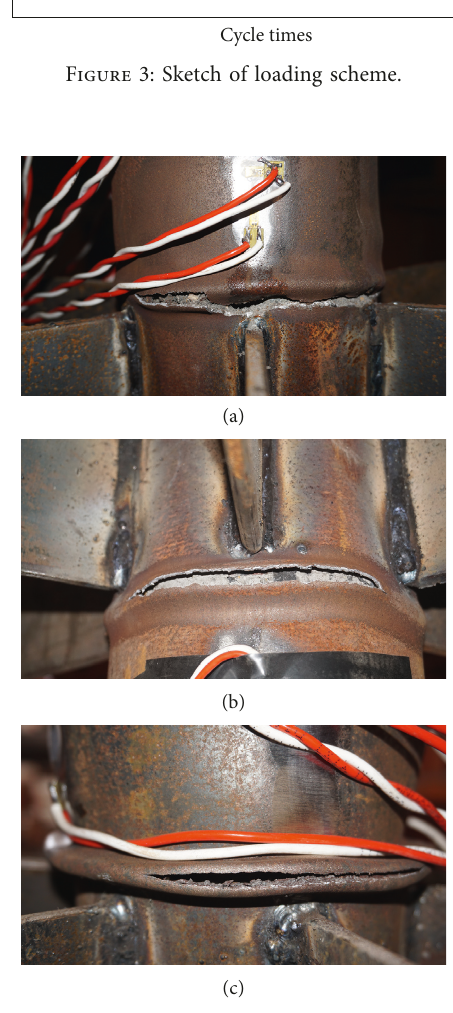
Figure 4: Failure modes of specimens. (a) Lower-end tearing of DWHP-1, (b) upper-end tearing of DWHP-2, and (c) lower-end tearing of